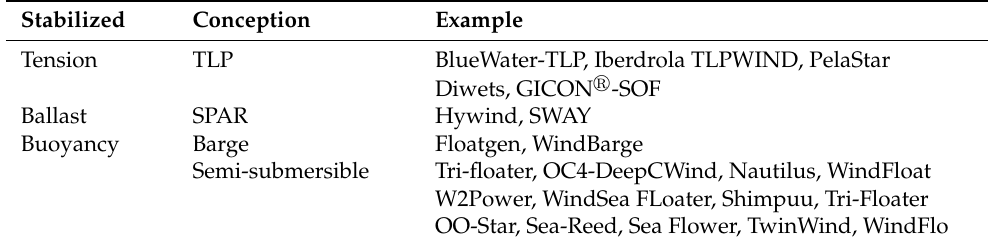
Table 1. Conceptions of different types of floating